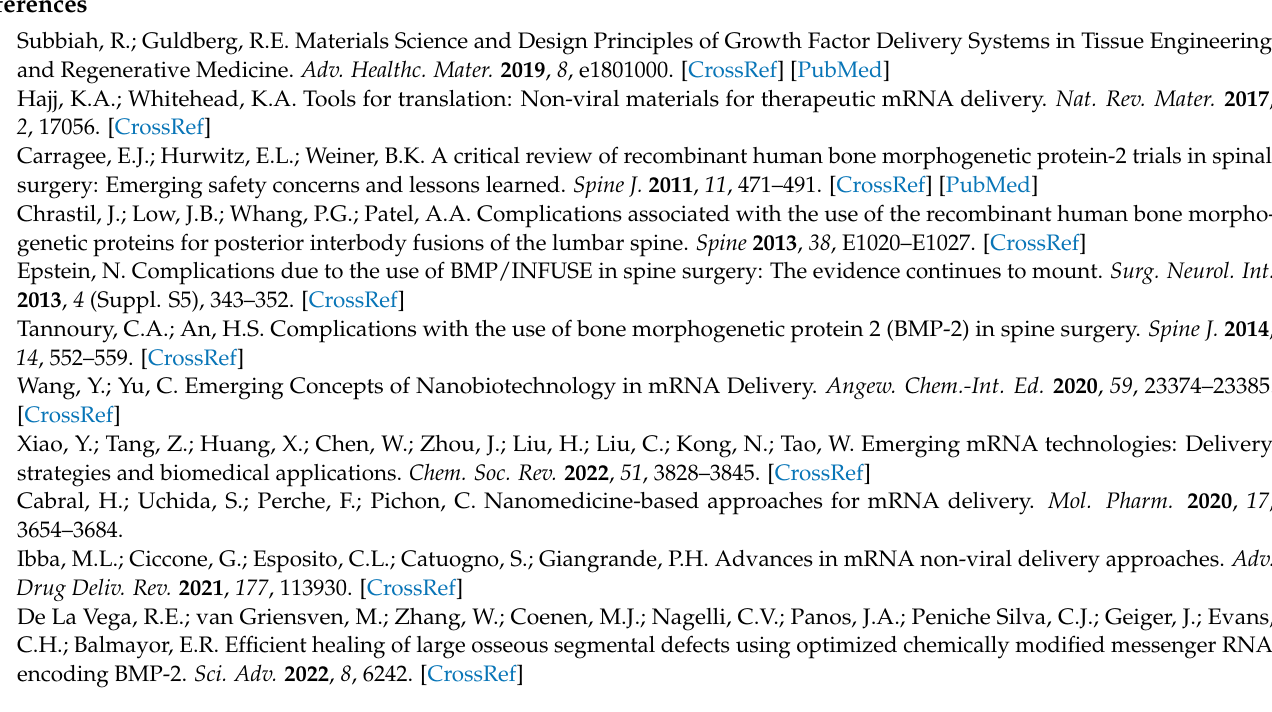
Figure S4: Internalization of gelatin nanoparticles. Quantification of internalization of gelatin nanopar- ticles by pre-osteoblastic cells after 24 h after normalization of original fluorescence based on Figure S3 ( n = 6). ns indicates no statistically significant differences. Figure S5: Endosomal release of mRNA. Ex- pression of luciferase mRNA 50 h after transfection with differently charged gelatin nanoparticles or commercial lipoplexes (LMM) and stimulation of endosomal escape by addition of chloroquine at dif- ferent time points ( n = 4). **** indicates statistically significant differences compared to untransfected control (no mRNA) with p <